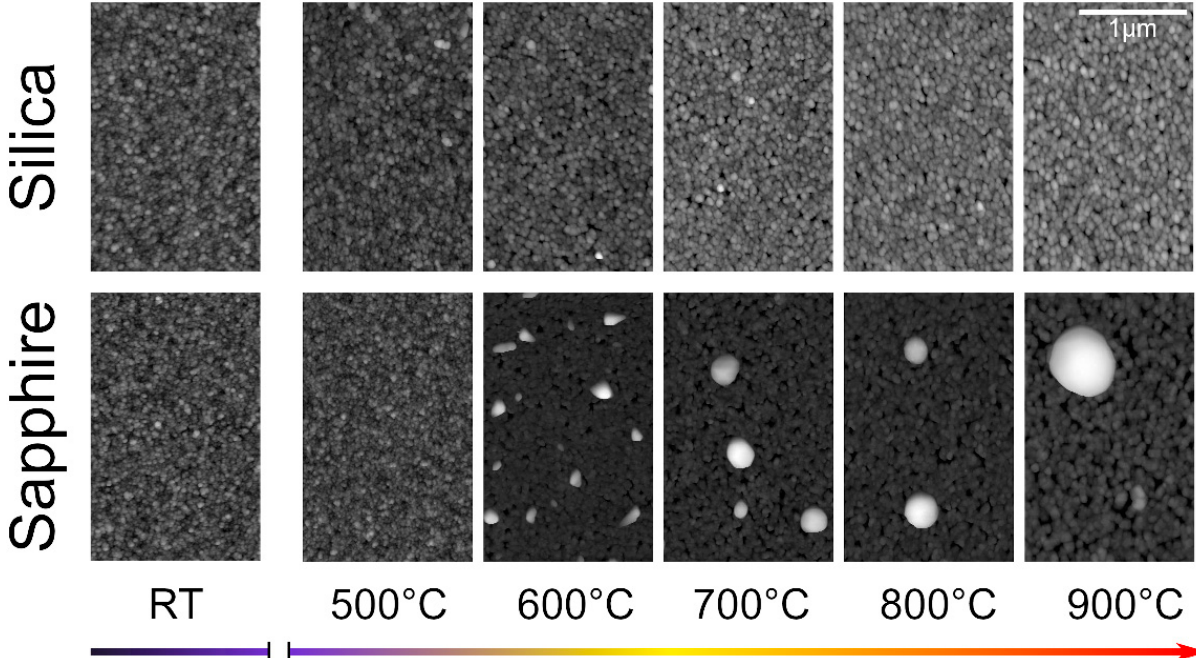
Figure 1 . AFM images of the Ag/TiO 2 (Ag/Ti 50–50) films on silica ( top ) and sapphire ( bottom ) as a function of the different annealing steps. Each image is 325 × 512 square pixels.